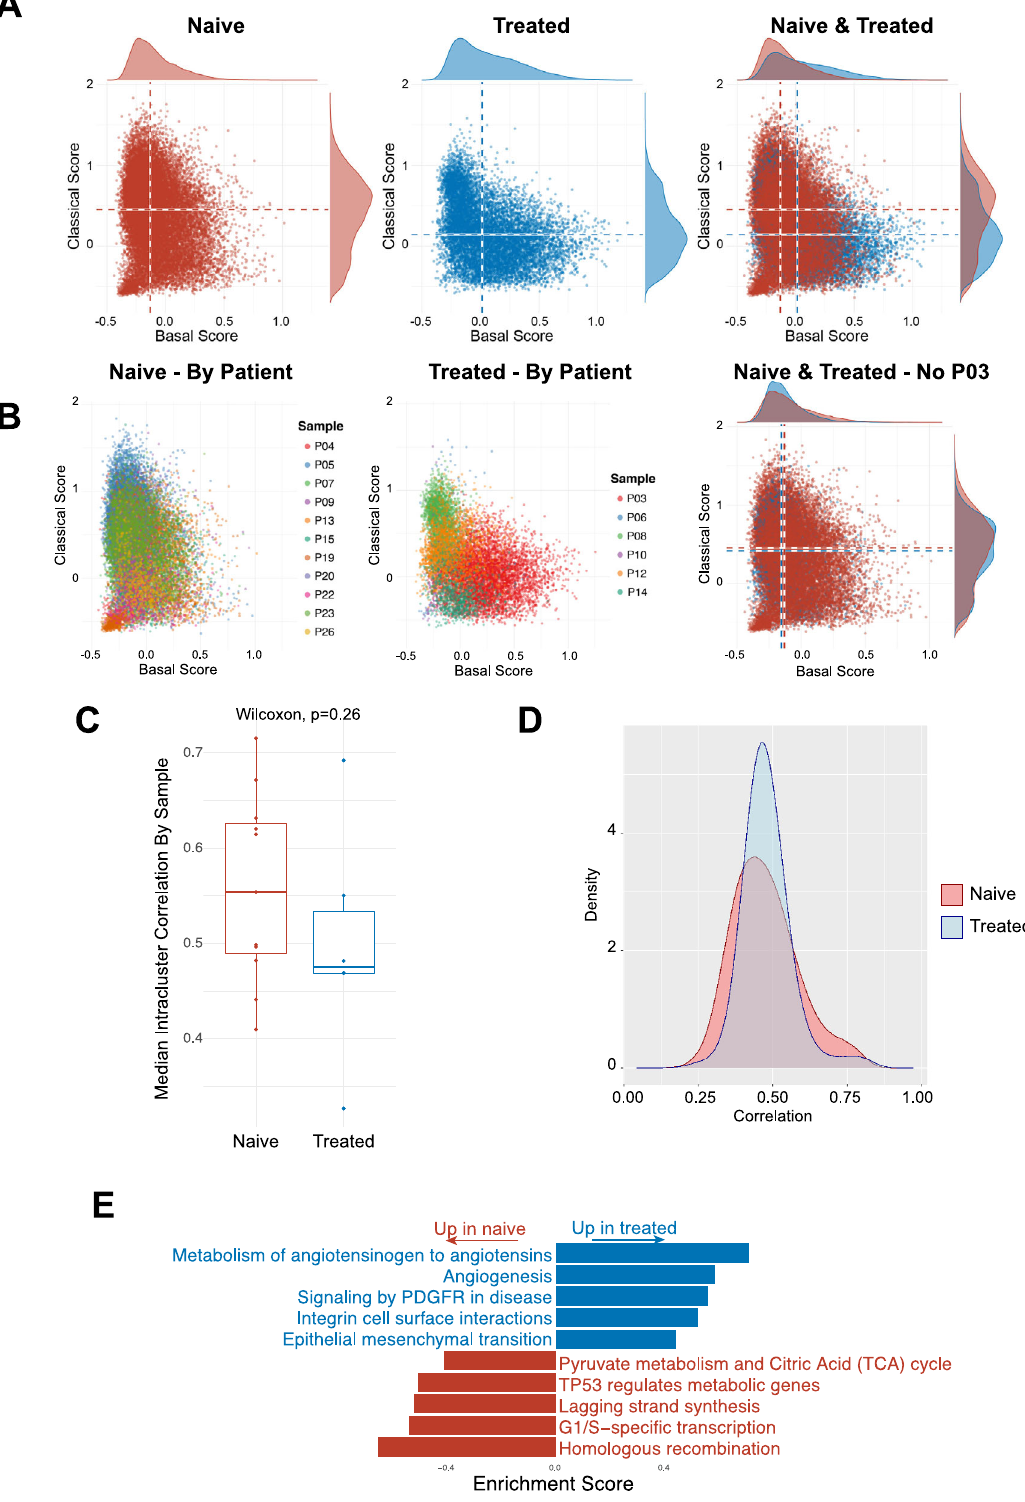
Fig. 6 | Chemotherapy treatment induces transcriptional changes in cancer cells independent of subtype. A Basal and classical signature expression scatter- plot of cancer cells (treated, naive and combined). B Basal and classical signature expression scatterplot of cancer cells (treated and naïve by patient, combined by treatment); sample P03 has been removed from the combined plot. C Box plot showing the median intracluster correlation of cancer cells by sample for treated